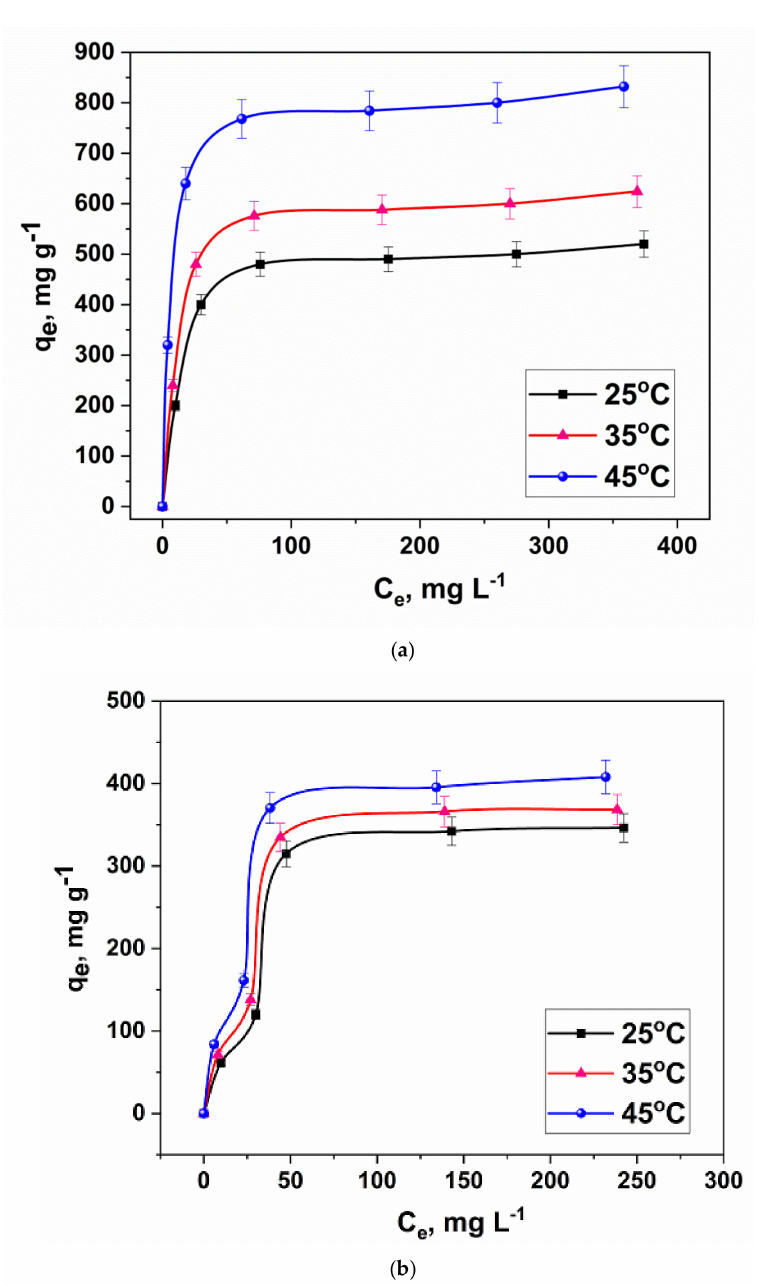
Figure 13. Sorption isotherms of ( a ): lead and ( b ): zinc ions by a nanocomposite at different